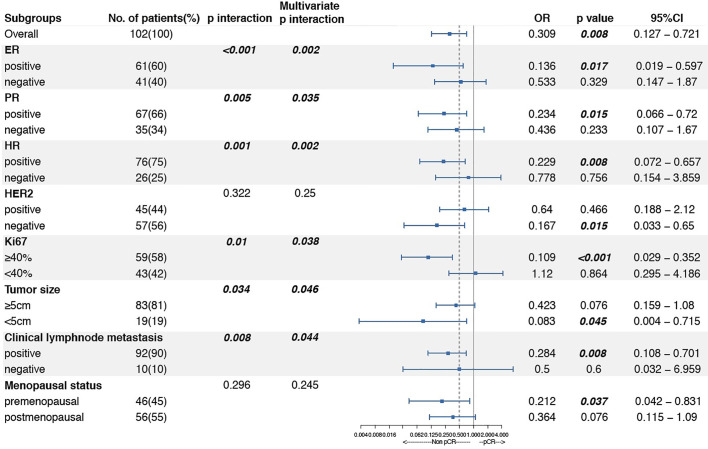
Subgroup analysis and interaction analysis between Linc00665 and clinicopathological factors regarding pCR after NAC.